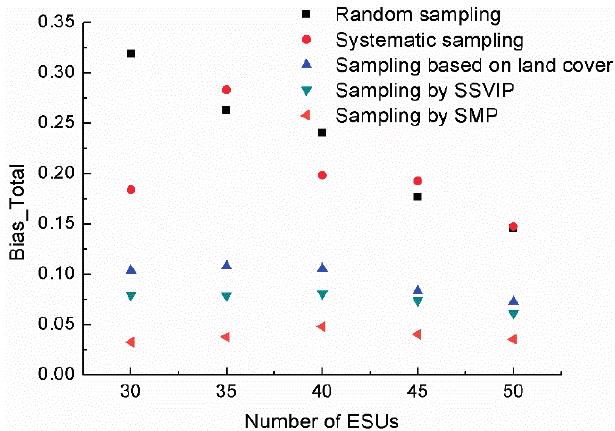
Figure 5. Mean bias between the ESUs and the entire sites in four images generated using the random sampling, systematic sampling, sampling based on the land cover map, SSVIP and SMP methods at different number of